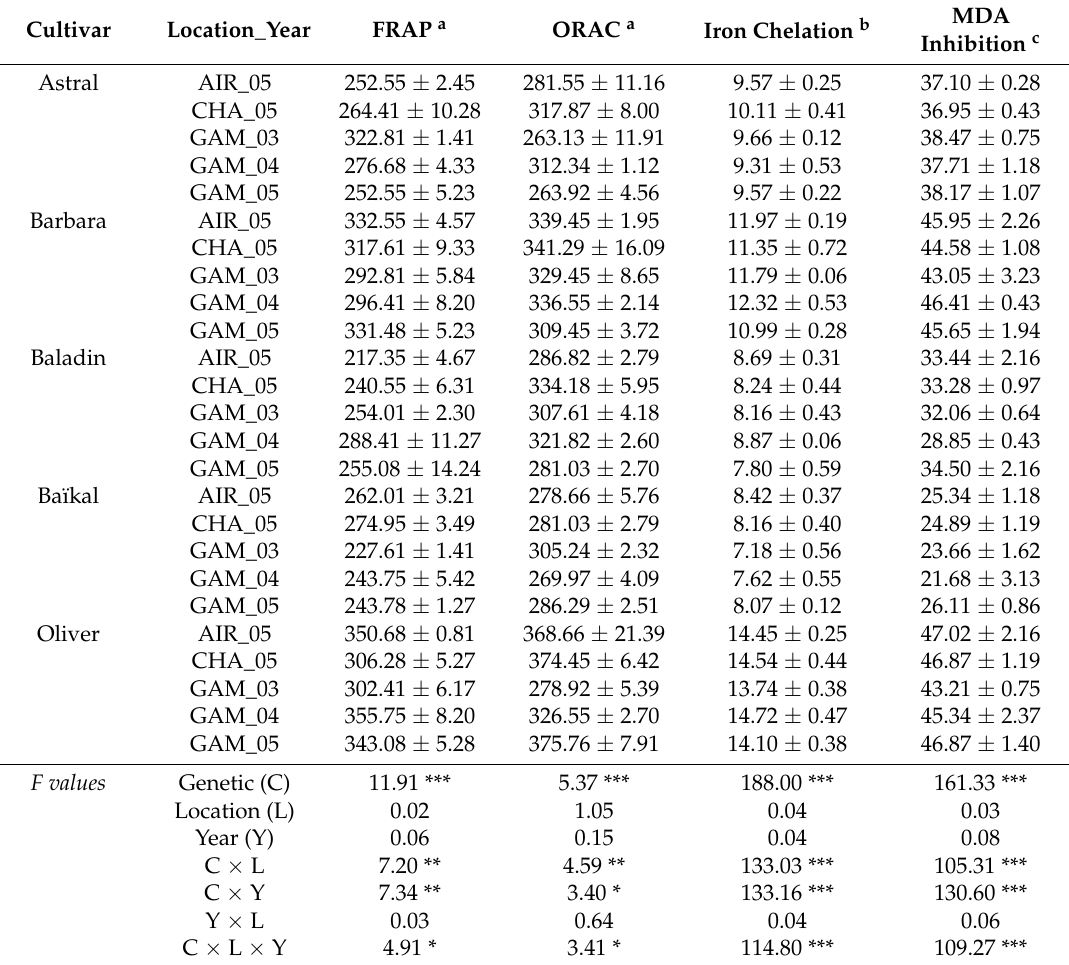
Table 3. Influence of the cultivar (C), cultivation site (L), and year (Y) on the in vitro and in vivo antioxidant activities of flaxseed